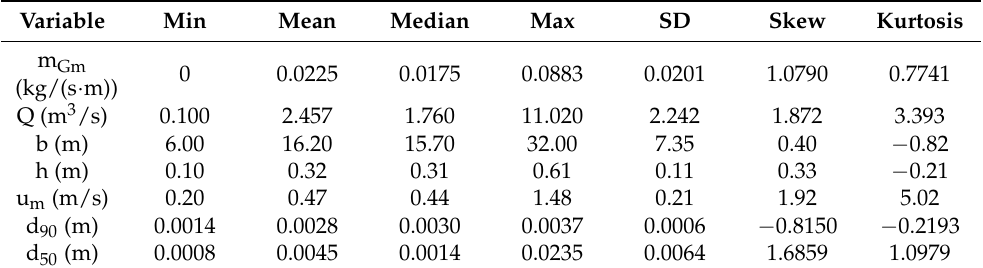
Table 1. The average statistical properties of bed load related values. SD is an abbreviation for standard deviation.